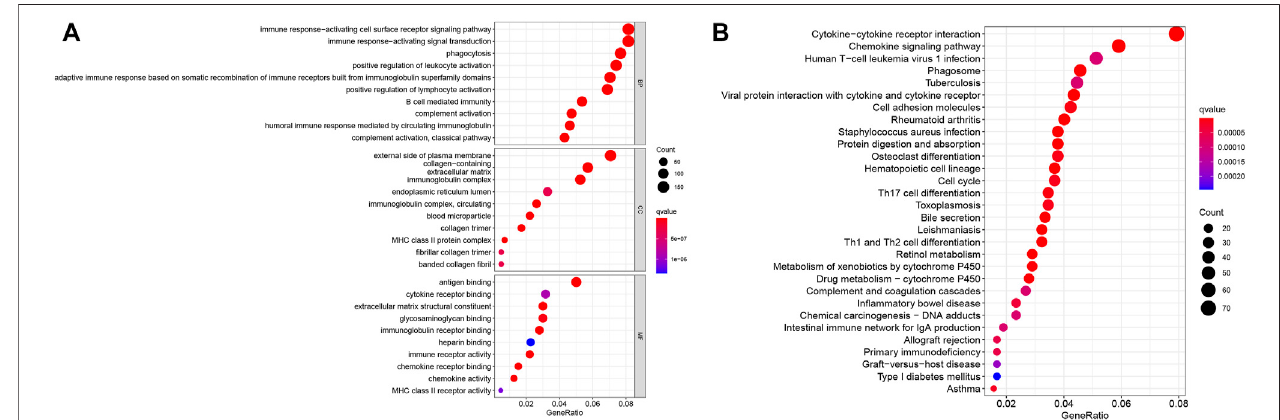
FIGURE 3 | Enrichment analysis of the differentially expressed genes. (A) GO analysis. (B) KEGG